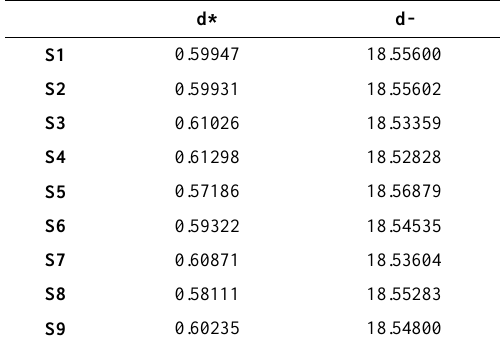
Table 14. Combined Value Matrix 𝒅 𝒊− and 𝒅 𝒊+ from Every Solution